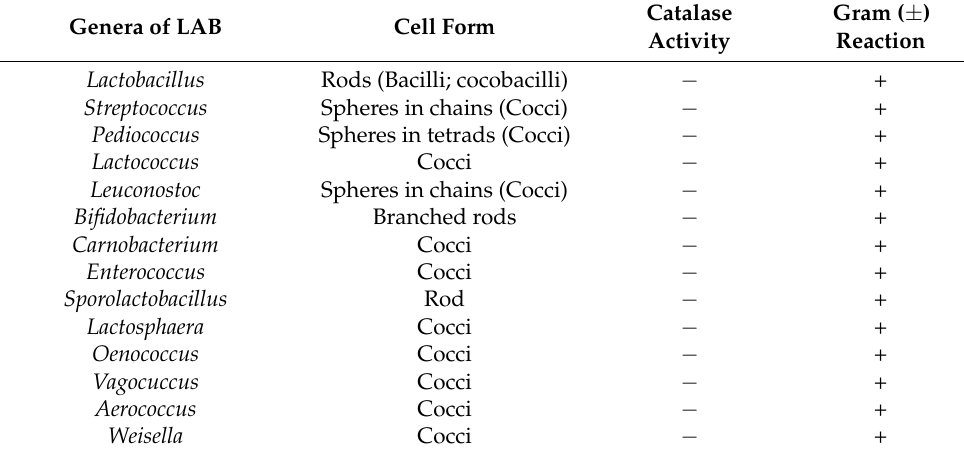
Table 1. Genera of lactic acid bacteria (LAB) involved in cereal fermentation. Catalase Gram ( ± ) Genera of LAB Cell Form Activity Reaction Lactobacillus Rods (Bacilli; cocobacilli) − + Streptococcus Spheres in chains (Cocci) − + Pediococcus Spheres in tetrads (Cocci) − + Lactococcus Cocci − + Leuconostoc Spheres in chains (Cocci) − + Bifidobacterium Branched rods − + Carnobacterium Cocci − + Enterococcus Cocci − + Sporolactobacillus Rod − + Lactosphaera Cocci − + Oenococcus Cocci − + Vagocuccus Cocci − + Aerococcus Cocci − + Weisella Cocci −